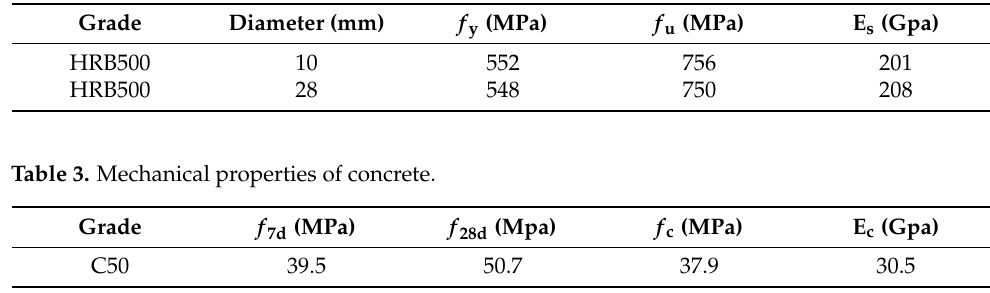
Table 2. Mechanical properties of reinforcements.